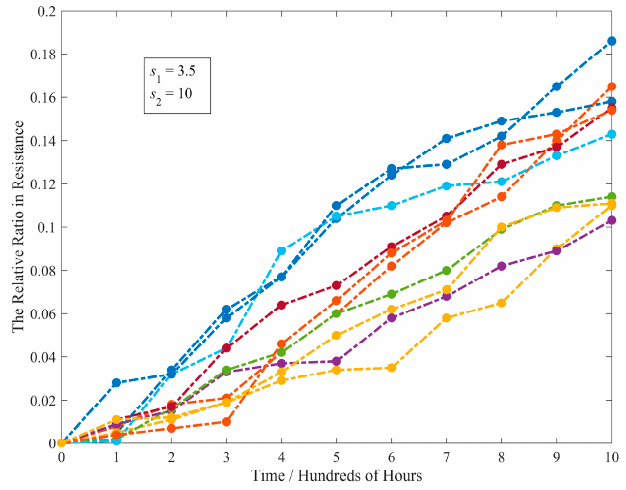
Figure 8. The degradation paths for ten resistors in CSADT ( s 1 = 3.5 and s 2 = 10).